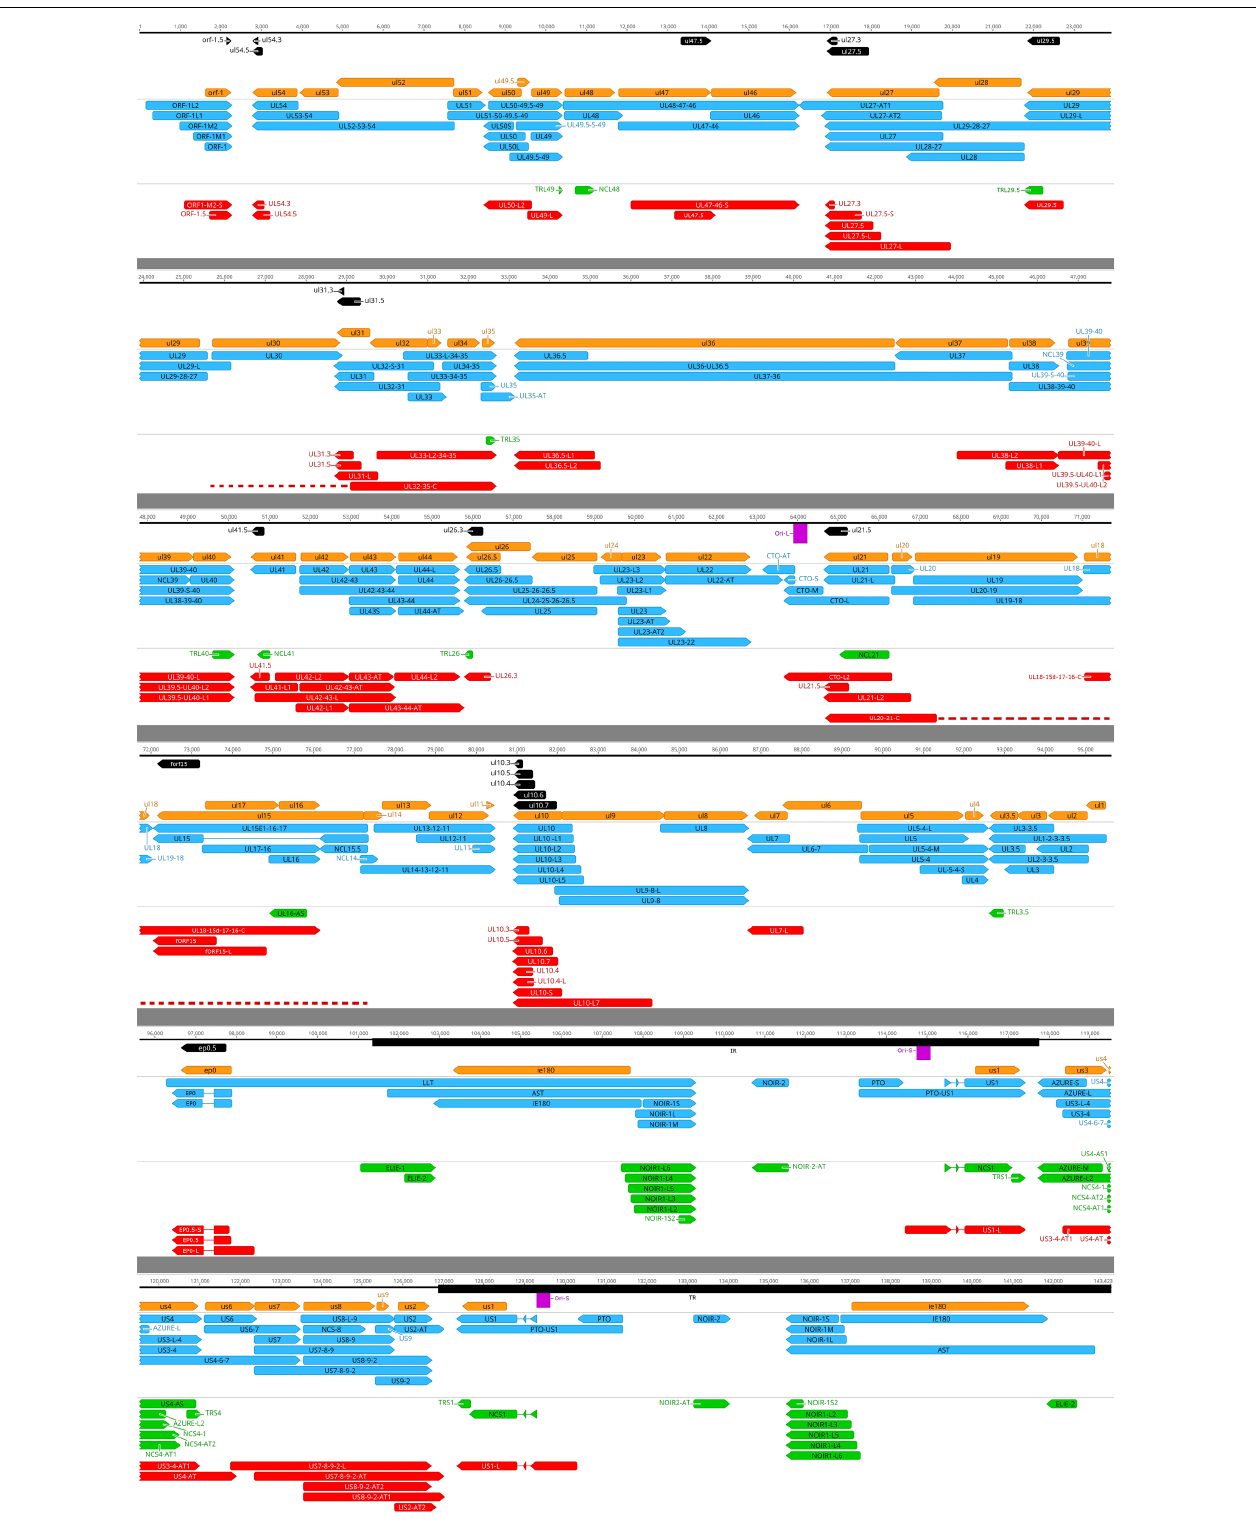
FIGURE 5 | Annotation of the PRV transcriptome. Coding sequences (CDS): orange arrow-rectangles; novel putative ORFs: black arrow-rectangles; already known transcript isoforms: blue arrow-rectangles; novel non-coding transcripts: green arrow rectangles; novel protein coding transcripts and transcript isoforms: red